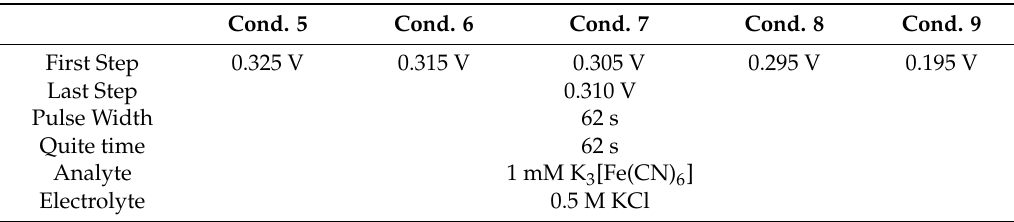
Table 4. DSC conditions for each experiment.